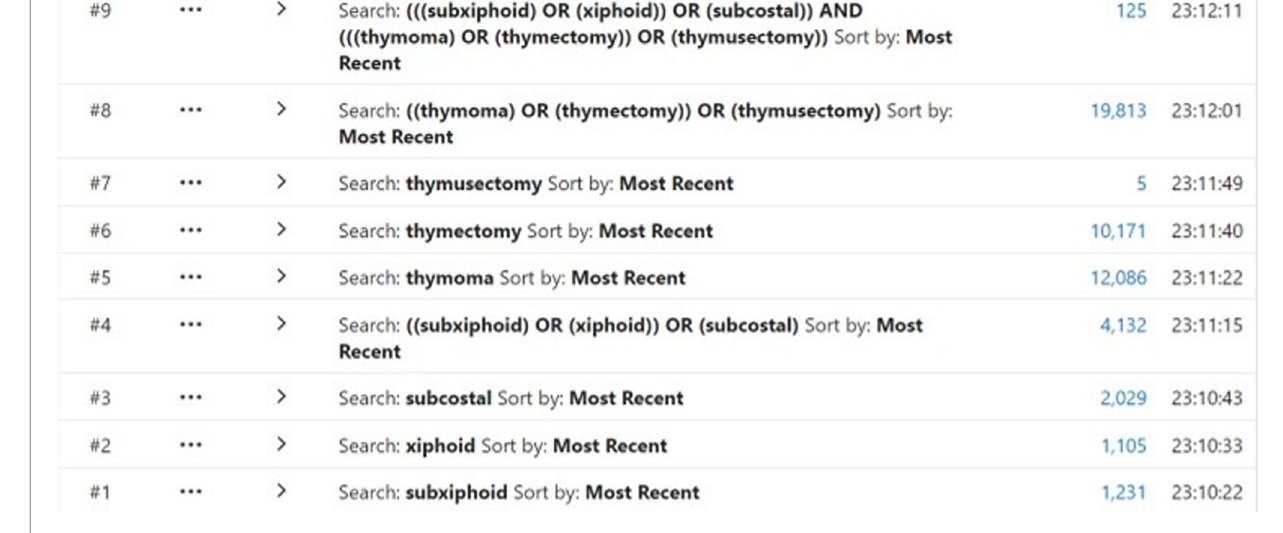
FIGURE 1 | Retrieval strategy.